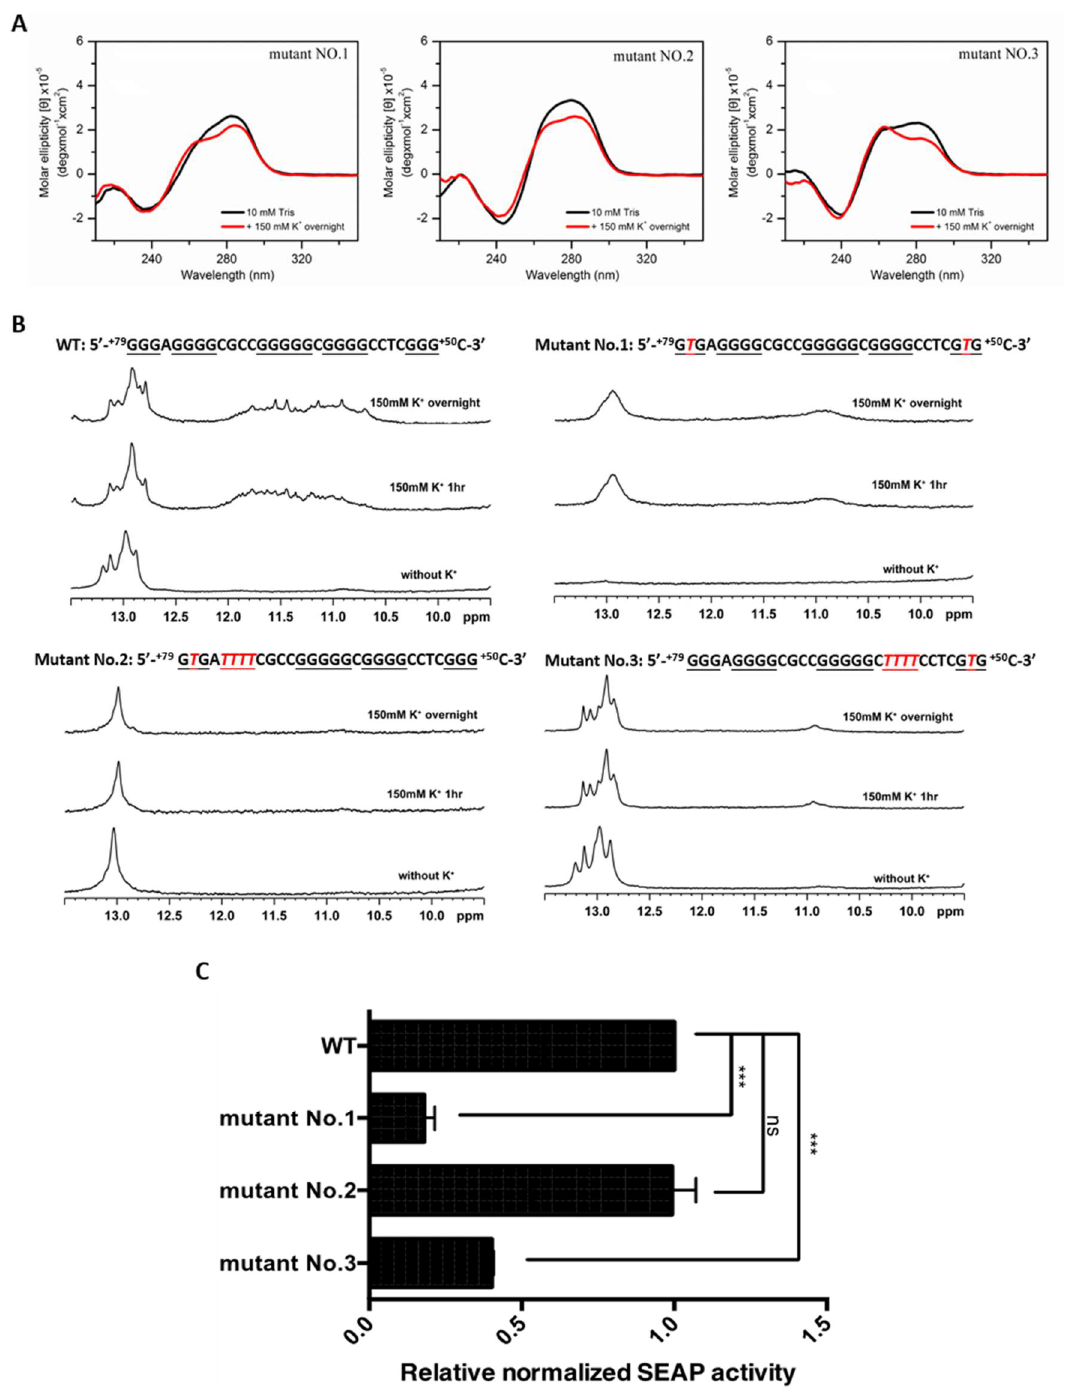
Figure 3. ( A ) The CD spectra of three mutants that disrupt the PG4-3 structure in Tris-HCl buffer without (black line) and with (red line) 150 mM KCl for overnight; ( B ) The imino proton NMR spectra of PG4-3 wild type (WT) and three mutants in Tris-HCl buffer without ( bottom panel) or with 150 mM KCl for 1 h ( middle panel) and overnight ( top panel). G-tracts are underlined, and the mutation sites are marked in red italicized letters; ( C ) The effects of the mutations that disrupt the G4-3 structure. Each mutant of CLIC4 p(−125, +285) was transfected in A375 cells. After 72 h, the media were collected for a SEAP assay. Data were expressed as the means ± SD of three replicates. *** p < 0.001, ns: non-significant difference as compared to WT control.